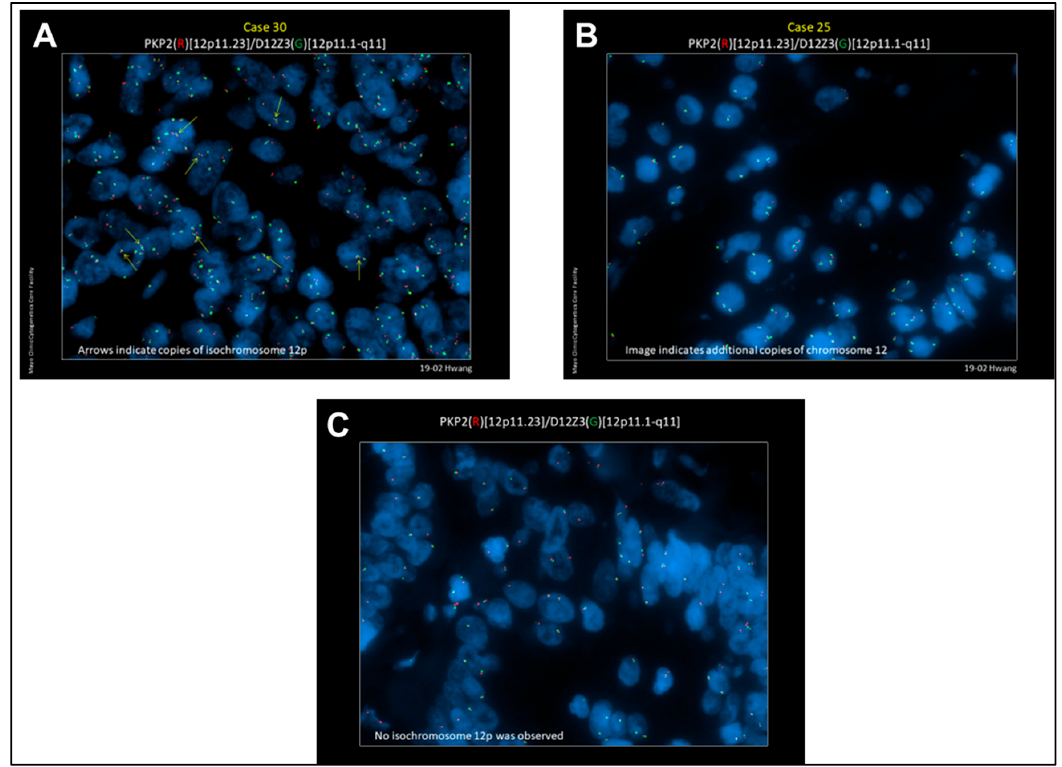
Figure 1. Representative FISH images. ( A ) Representative image (patient #4) demonstrating detection of i(12p) by FISH using PKP2 DNA probe labeled with SpectrumOrange and D12Z3 probe labeled with SpectrumGreen (see text for details). ( B ) Representative image (patient #13) demonstrating additional copies of chromosome 12 without detection of i(12p). ( C ) Representative image demonstrating a negative control.